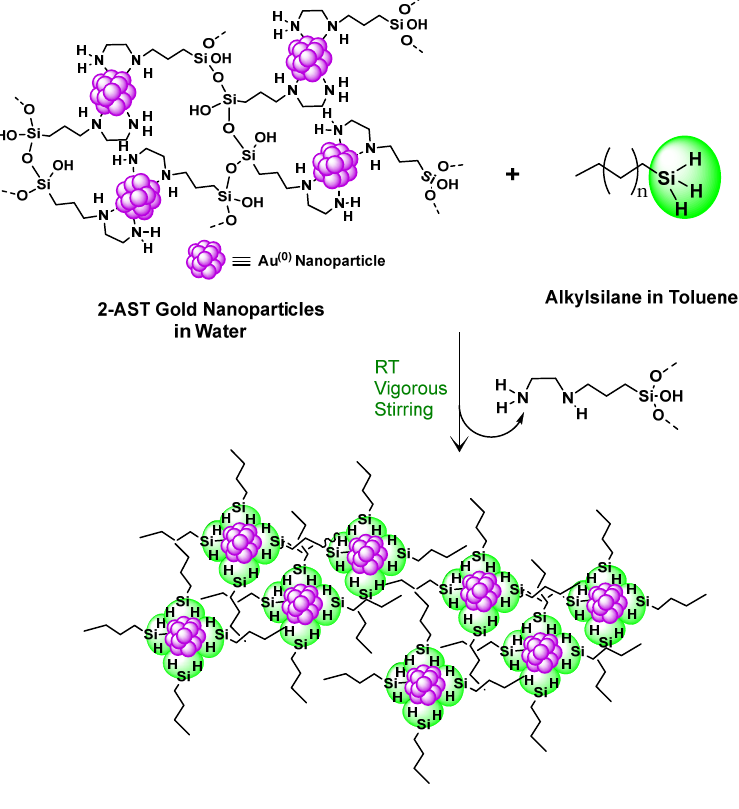
Table 1. Comparative study of alkylsilanes as phase transfer agents. Silanes Octadecylsilane (ODS)